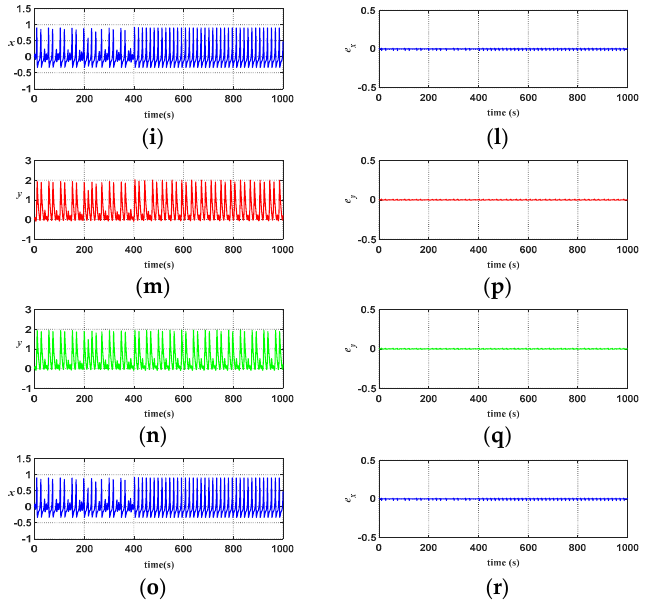
Figure 19. Comparisons on simulation results of chaotic system stability control: ( a ) Phase diagram of uncontrolled chaotic system; ( b ) Phase diagram of uncontrolled chaotic system; ( c ) Phase diagram of uncontrolled chaotic system; ( d ) Stable phase diagram for CMAC; ( e ) Stable phase diagram for FCMAC; ( f ) Stable phase diagram for ATFSORC; ( g ) x response for CMAC; ( h ) x response for FCMAC; ( i ) x response for ATFSORC; ( j ) Error e x for CMAC; ( k ) Error e x for FCMAC; ( l ) Error e x for ATFSORC; ( m ) y response for CMAC; ( n ) y response for FCMAC; ( o ) y response for ATFSORC; ( p ) Error e y for CMAC; ( q ) Error e y for FCMAC; ( r ) Error e y for ATFSORC.